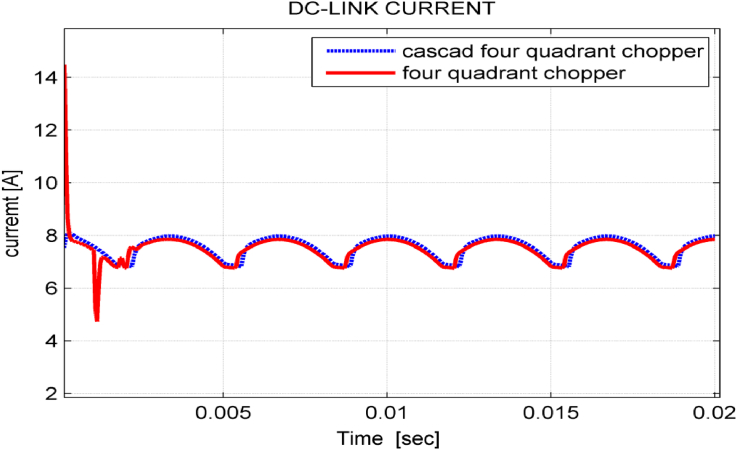
dc – link current.